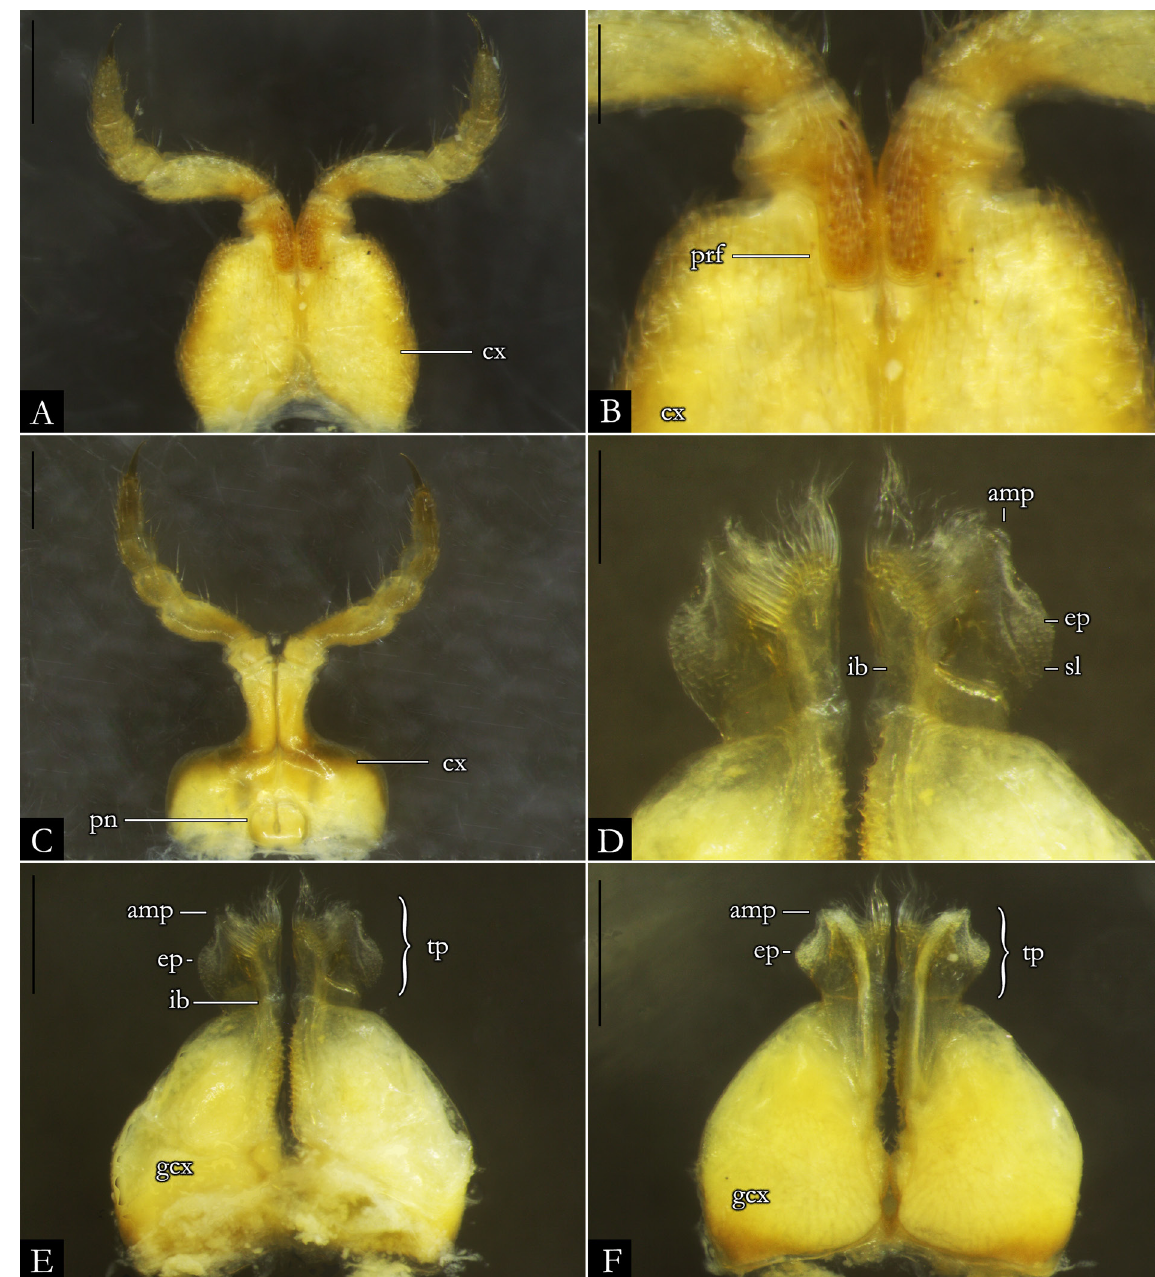
Fig. 133. Pseudonannolene tocaiensis Fontanetti, 1996, paratype, ♂ (MZSP 942). A . First leg-pair. B . Detail of prefemur. C . Second leg-pair. D . Detail of telopodites, in anal view. E . Gonopods, in anal view. F . Gonopods, in oral view. Abbreviations: see Material and methods. Scale bars: A, C, E–F = 0.5 mm; B, D = 0.2